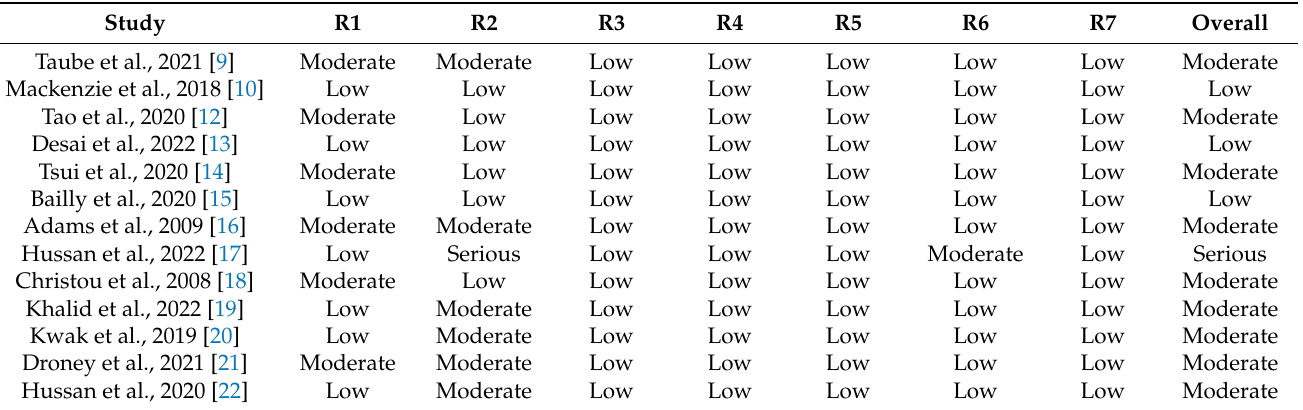
Table 2. Risk of bias summary for non-randomized studies using the ROBINS-I tool. R1 = bias due to confounding, R2 = bias due to selection of participants, R3 = bias in classification of interventions, R4 = bias due to deviations of intended interventions, R5 = bias due to missing data, R6 = bias in measurement of outcomes, and R7 = bias in selection of the reported